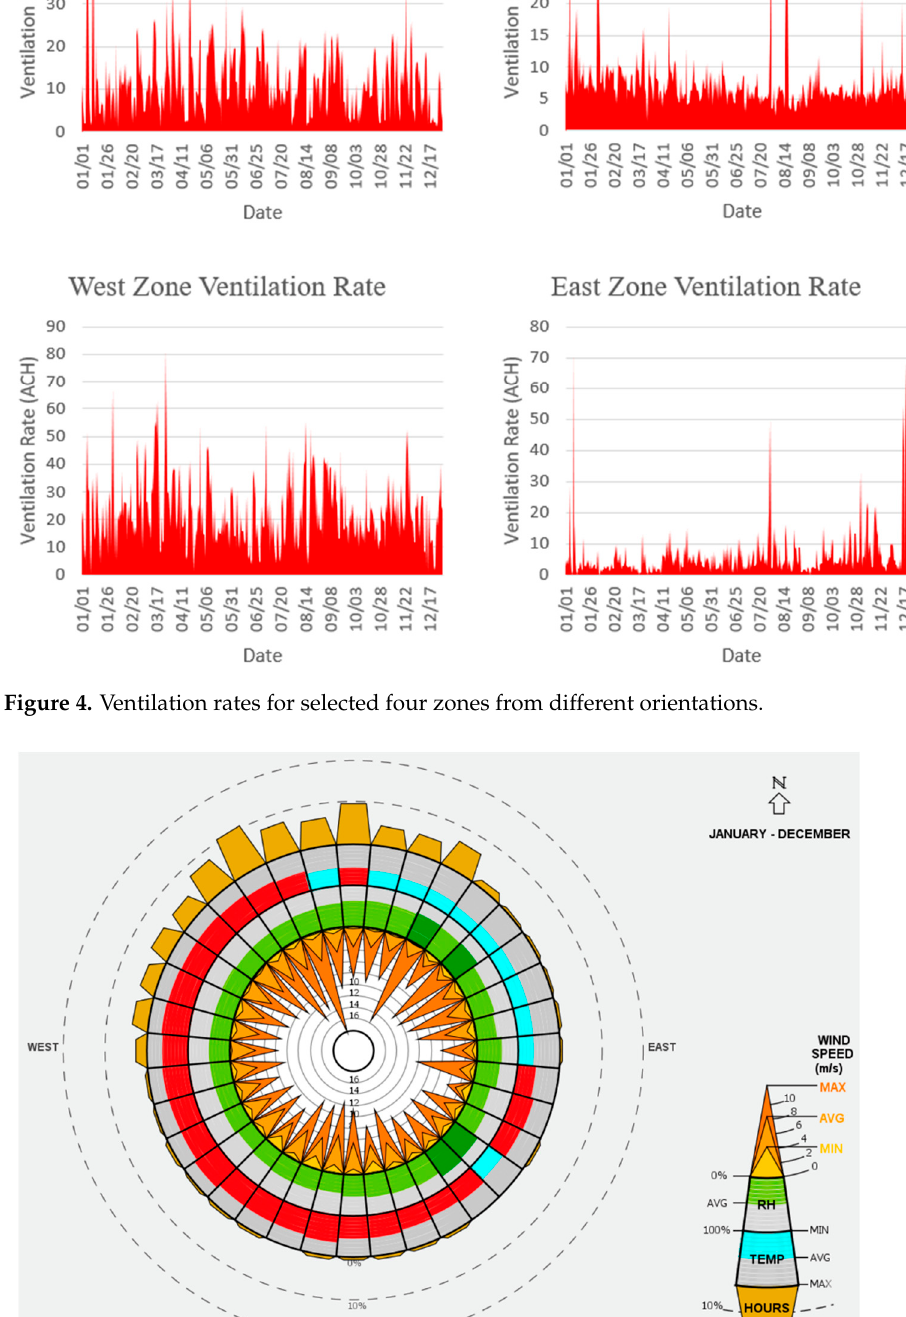
Figure 6. The effect of windows opening fraction on the ventilation rate of the building. The ASHRAE 62.2 standard (Ventilation and Acceptable Indoor Air Quality in Resi- dential Buildings) [61] defines the minimum air ventilation requirements for mechanical and natural ventilation systems based on the floor area of the dwelling unit. According to ASHRAE 62.2, the corresponding air ventilation rate requirement for the dwelling floor area (about 360 m 2 ) is 77 L/s which is about 0.26 ACH. Apparently, the air change rate recommended by ASHRAE is way below the average air change rate in the residential building introduced in this study. As stated previously, ASHRAE 62.2 defines the general roles for minimum ventilation requirements to provide acceptable indoor air quality in residential buildings, however, these minimum requirements could not be enough to eliminate airborne infection transmission. The World Health Organization (WHO) published a report [17] that discussed natu- ral ventilation requirements for infection control in health-care settings. The report rec- ommended an average ventilation rate of 160 L/s/patient for airborne precaution rooms,